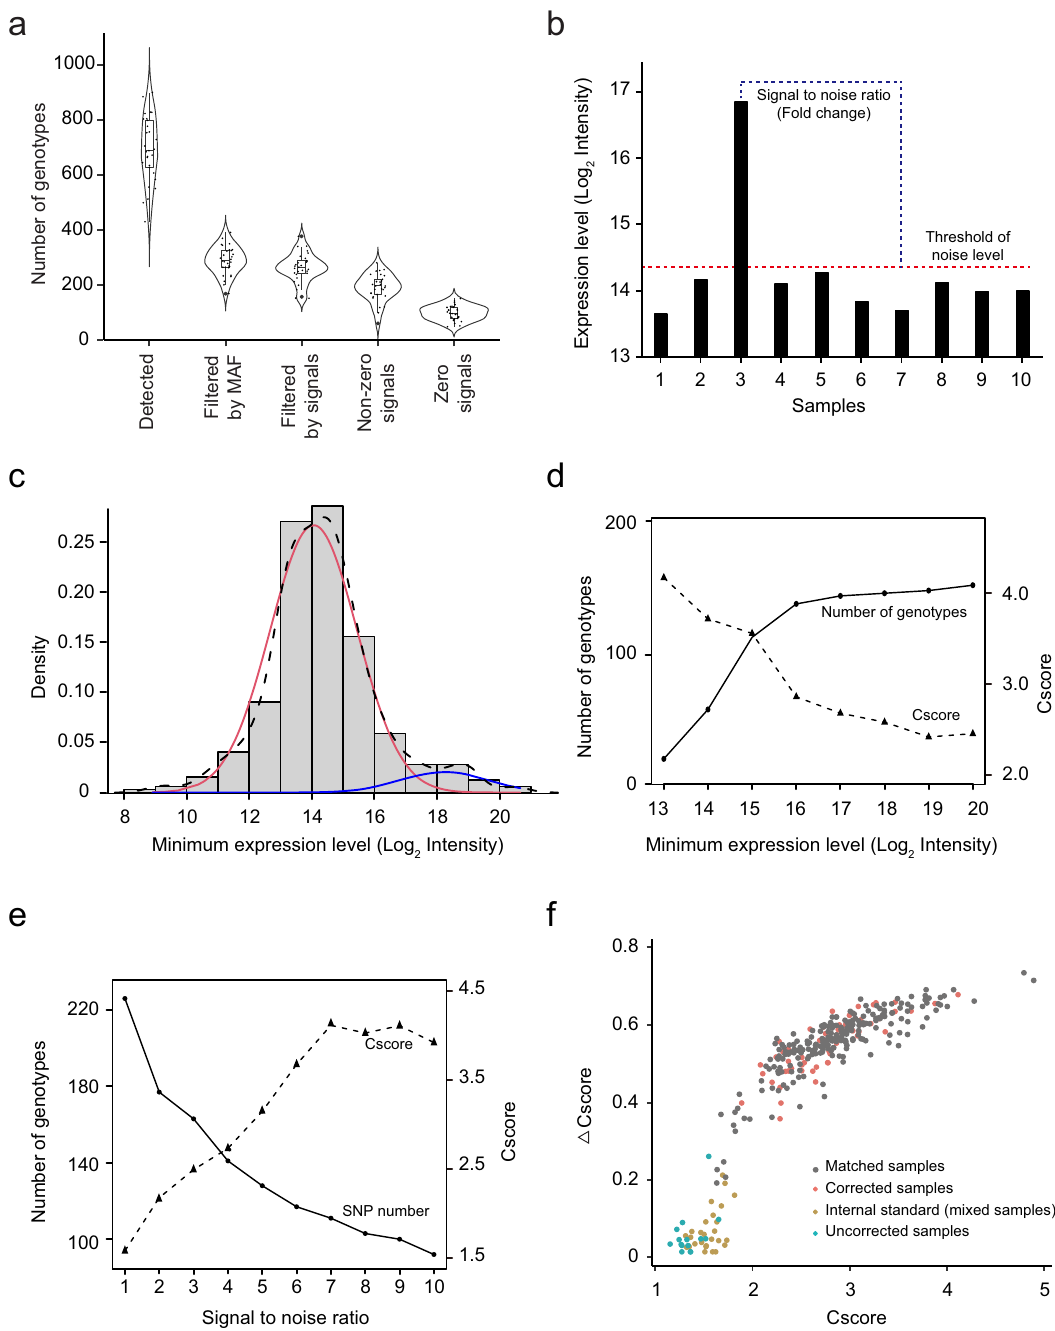
Fig. 3 Application of SMAP to the PsychENCODE BrainGVEX proteomic data. ( a ) Distribution of the number of SNPs identi fi ed, fi ltered by both minor allele frequency (MAF), threshold of the noise signal, and identi fi ed variant peptides with and without zero signals. The numbers of genotypes from 29 batches are shown as violin and box-and-whisker plots. The box-and-whisker plot indicates the median (line within box), 25 – 75% quartile range (box), and 10 – 90% range (whiskers). ( b ) Diagram showing how to de fi ne the threshold of the noise background and the signal-to-noise (S/N) ratio. ( c ) Distribution of minimum signals of identi fi ed variant peptides. The minimum expression can be separated into noise and signal distributions by the expectation- maximum (EM) method: all values (black dash line), noise values (red solid line), and signal values (blue solid line). ( d ) The distributions of the number of genotypes and Cscore with different thresholds of the minimum expression level. ( e ) The distributions of the number of genotypes and Cscore with different S/N ratios. ( f ) Score distribution of matched samples, corrected samples, internal controls, and uncorrected samples across all 29 genotype (BB) and the nonmutant homozygous genotype (AA) After optimizing the parameters, we used 7628 fi ltered SNPs to showed that an S/N value of 3 achieves a reasonably good number infer genotypic information for 288 biological samples and 31 of genotypes and Cscore (Fig. 3e). Following fi ltration by the controls in the PsychENCODE BrainGVEX proteomic data minimum signal and the S/N ratio, we detected 7628 genotypes, (Supplementary Data 2). The genotypic information of each with an average of 263 genotypes per batch (Fig. 3a). sample was then inferred based on its expression level in a batch